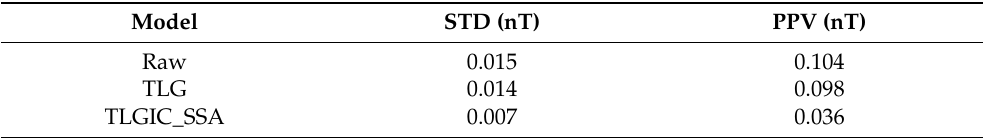
Figure 6. Compensation results of measured magnetic data in low–altitude flight by utilizing TLG and TLGIC_SSA compensation models. ( a ) low–altitude flight data before and after compensation; ( b ) compensated total magnetic field data measured by the fluxgate vector magnetometer. Table 3. Compensation results during a low-altitude